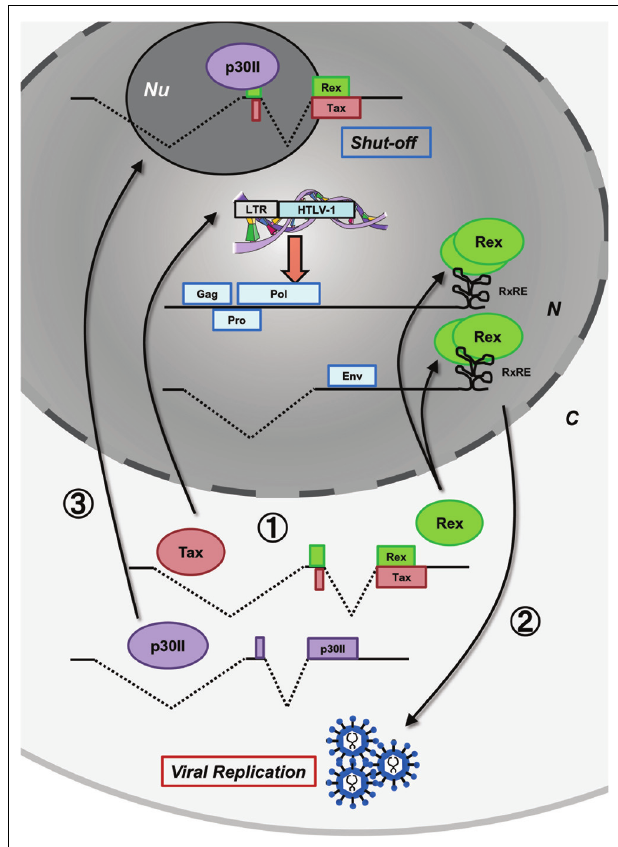
FIGURE 1 | Concerted functions of viral proteins for HTLV-1 expression. Postinfection, the HTLV-1 provirus expresses viral proteins at appropriate times to control the early productive phase and the late shut-down phase leading to latency in the HTLV-1 life cycle. At the very beginning, without Rex, the viral transcripts are fully spliced and thus,Tax and Rex are selectively translated (stage 1).Tax transactivates HTLV-1 LTR promoter activity, whereas Rex inhibits splicing and actively exports the unspliced and singly spliced viral mRNA from the nucleus resulting in the expression of structural proteins and production of viral particles (stage 2). In the late phase, p30II from a minor, doubly spliced transcript binds to tax/rex mRNA and confines it to the nucleoli (stage 3) resulting in decreasedTax/Rex protein levels leading to latency. N, nucleus; C, cytoplasm; Nu,